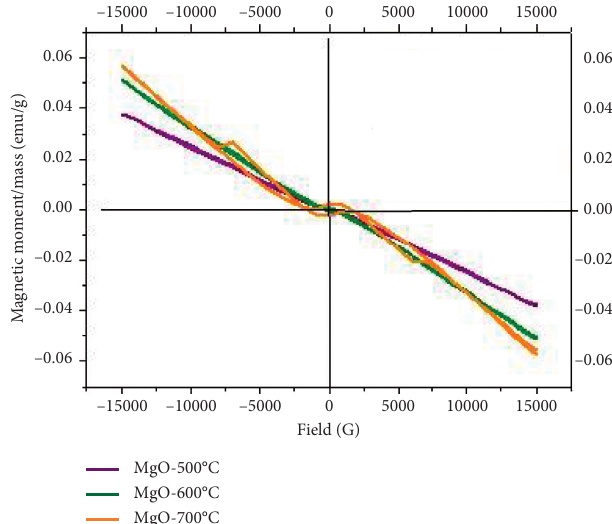
Figure 18: M–H curve of MgO nanoparticles at the room